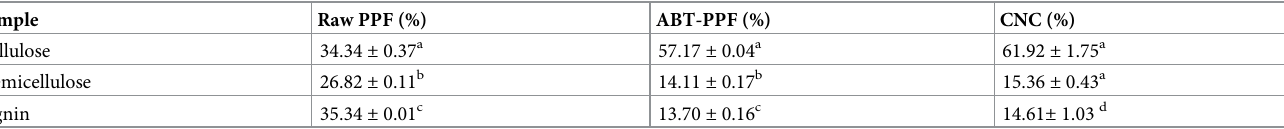
Averages are means of two determinations ± standard deviation. abc represents the values within the same row with same letters were significantly different (p < 0.05) from each other. ABT-PPF = Alkali and bleach treated PPF.